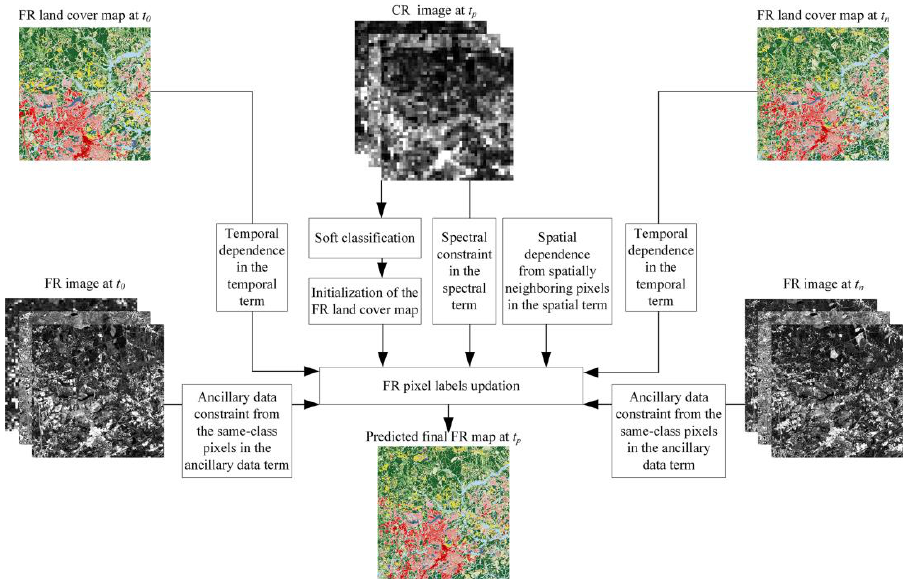
Figure 1. The flowchart of same-class pixels-based STSPM model (SCPSM) .